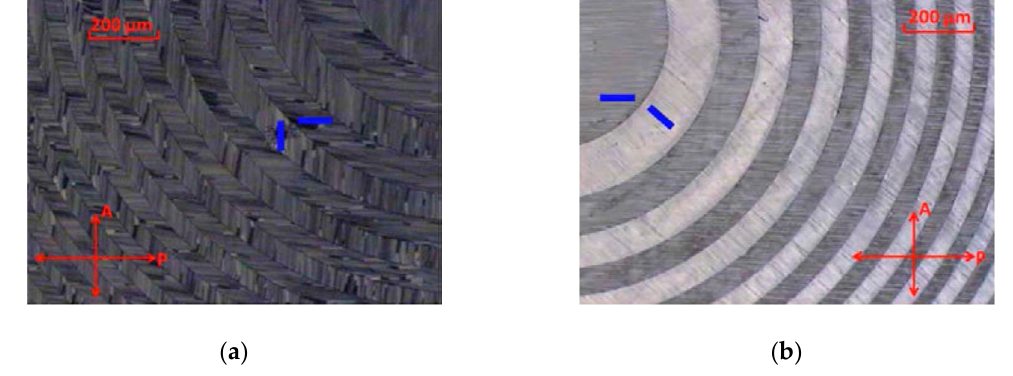
Figure 11. Microphotographs of two designed ferroelectric liquid crystal Fresnel zone lens under crossed polarizers. The blue lines indicate the alignment directions. ( a ) ferroelectric liquid crystal Fresnel zone lens (Rin 360 µm) with β 90°. ( b ) ferroelectric liquid crystal Fresnel zone lens (Rin 255 µm) with β 45°. Reprinted with permission from [168]. Copyright 2015 Optical Society of America.